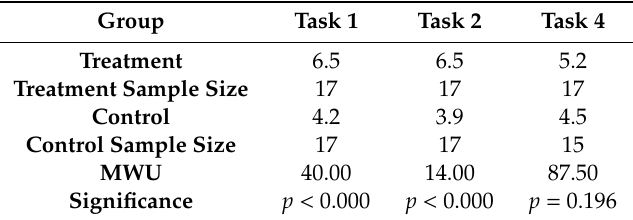
Table 7. Online presence tasks